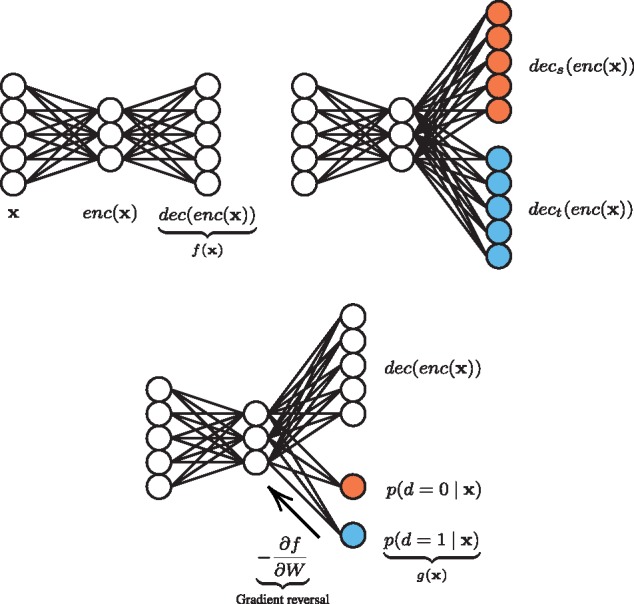
Multi-task autoencoders used for dimensionality reduction over multi-cell-line data. Clockwise from top left: vanilla autoencoder, multi-task autoencoder and DAA. Coloring indicates separate treatment of each domain (cell line)